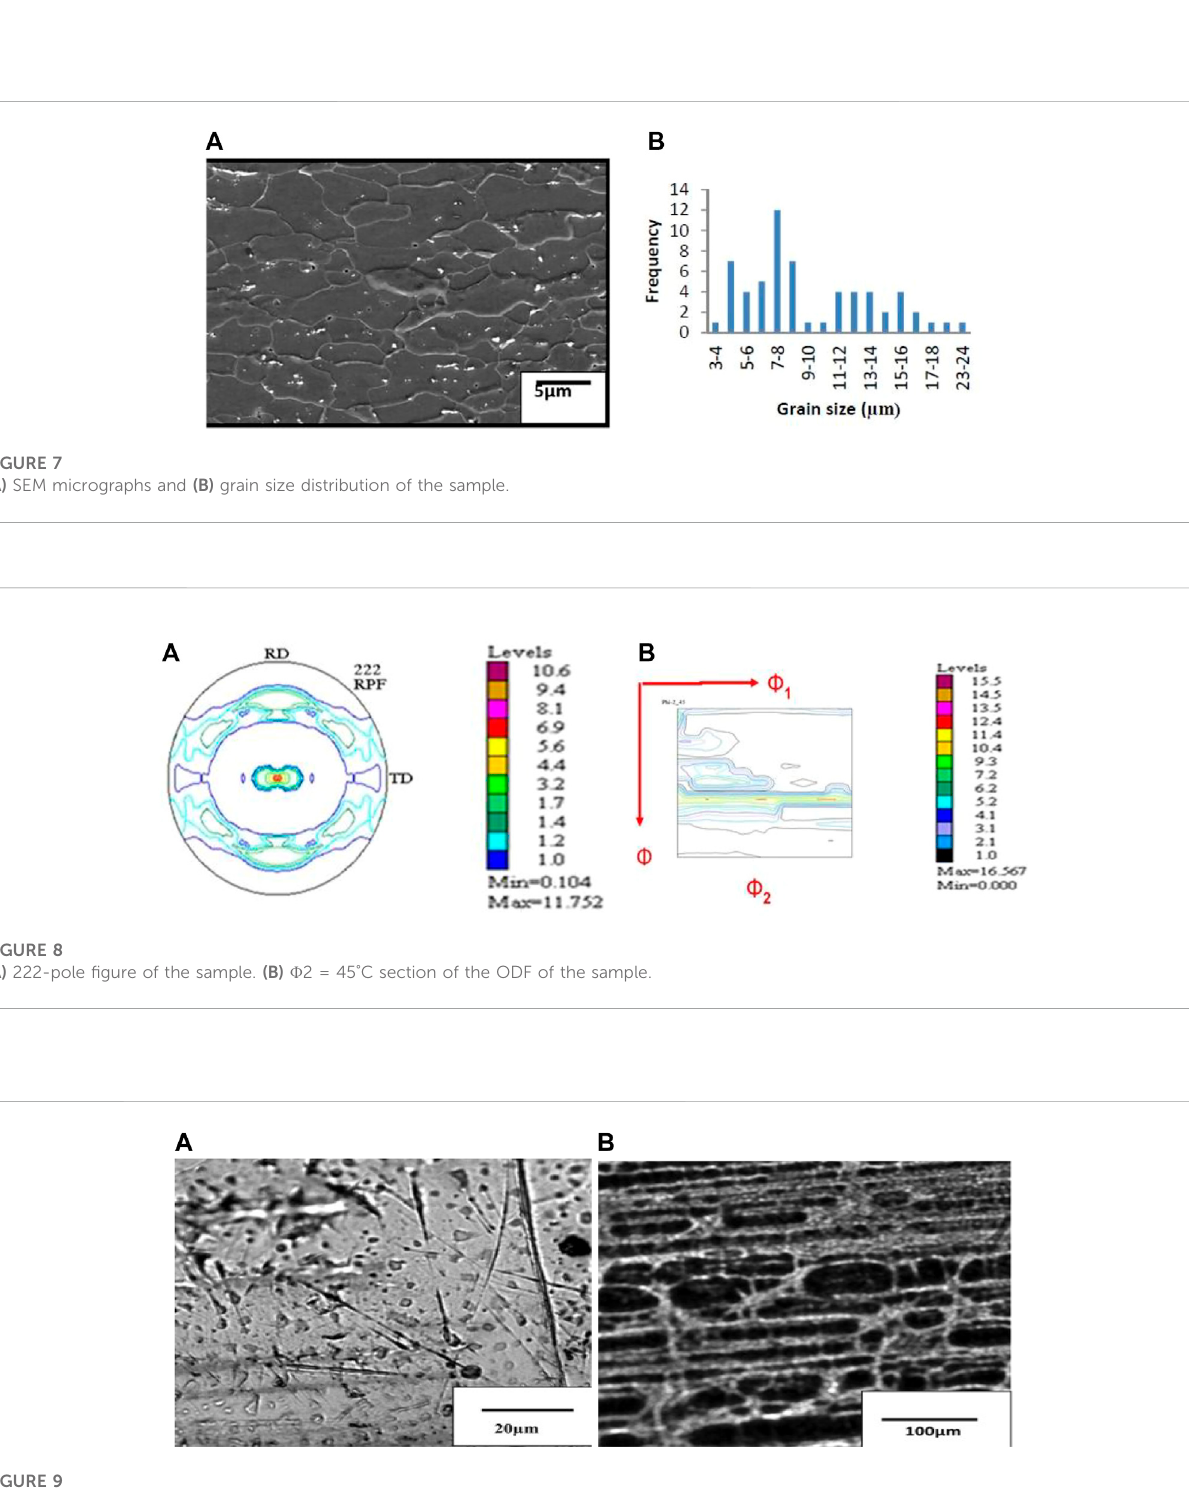
FIGURE 9 Optical micrographs of the sample show the top surface of coated steel at (A) low and (B) higher magni fi cations.